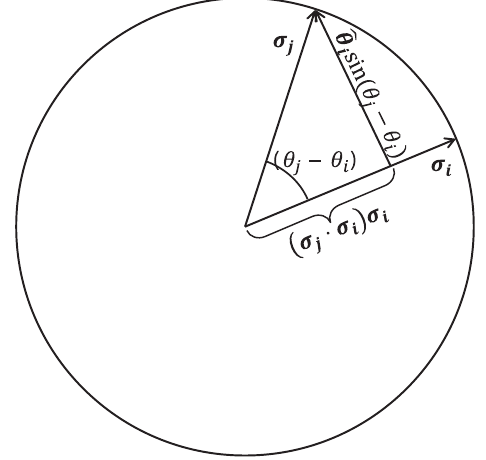
ˆ θ − ð σ σ − θ · σ sin ð θ , j j i Þ i (cid:2)¼ i j i Þ i